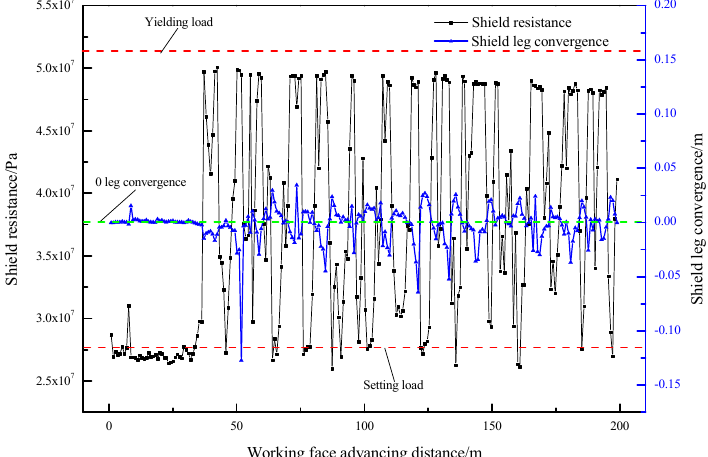
Figure 7. Changes of shield resistance and leg convergence under 4.5 m mining height. For a 5.0 m mining height, the shield resistance was also below the yield load. The maximum shield resistance was 50.1 MPa, the average resistance of the shield was 37.3 MPa, and the single maximum shrinkage of the shield column was 127.0 mm. The first weighting interval of the basic roof was 36.3 m, the periodic weighting interval of the basic roof was 8.8–12.5 m, and the average periodic weighting interval was about 11.5 m, as shown in Figure 8. Figure 8. Changes of shield resistance and leg convergence under 5.0 m mining height. As shown in Figure 9, the shield resistance was also below the yield load under a 5.5 m mining height, but close to the yield load. The maximum resistance of the shield was 50.5 MPa, the average shield resistance was 39.9 MPa, and the single maximum shrinkage of the shield column was 159.0 mm. The first weighting interval of the basic roof was 38.0 m, the periodic weighting interval of the basic roof was 10.5–12.0 m, and the average pe- riodic weighting interval was about 11.0 m.